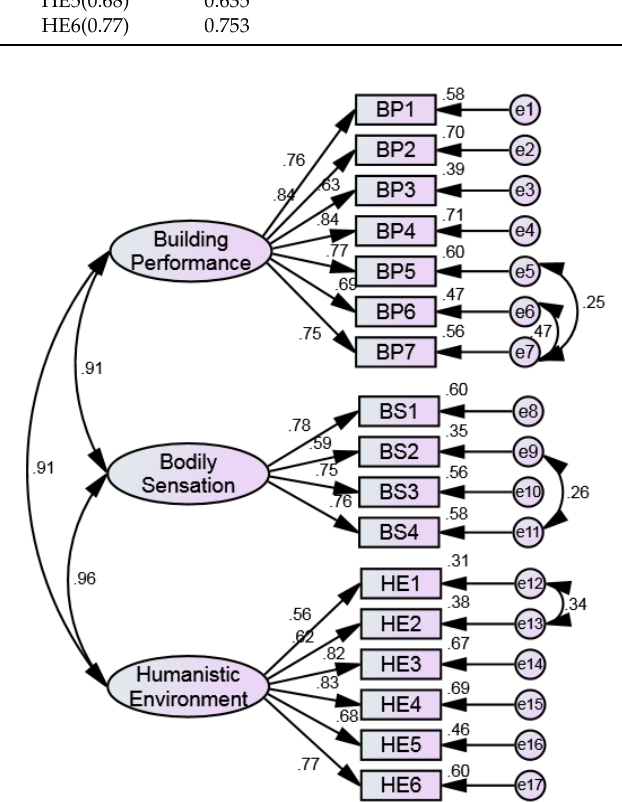
Figure 4. Standardized regression weights of the measurement model. Table 3. Parameters of convergent and discriminant validity.